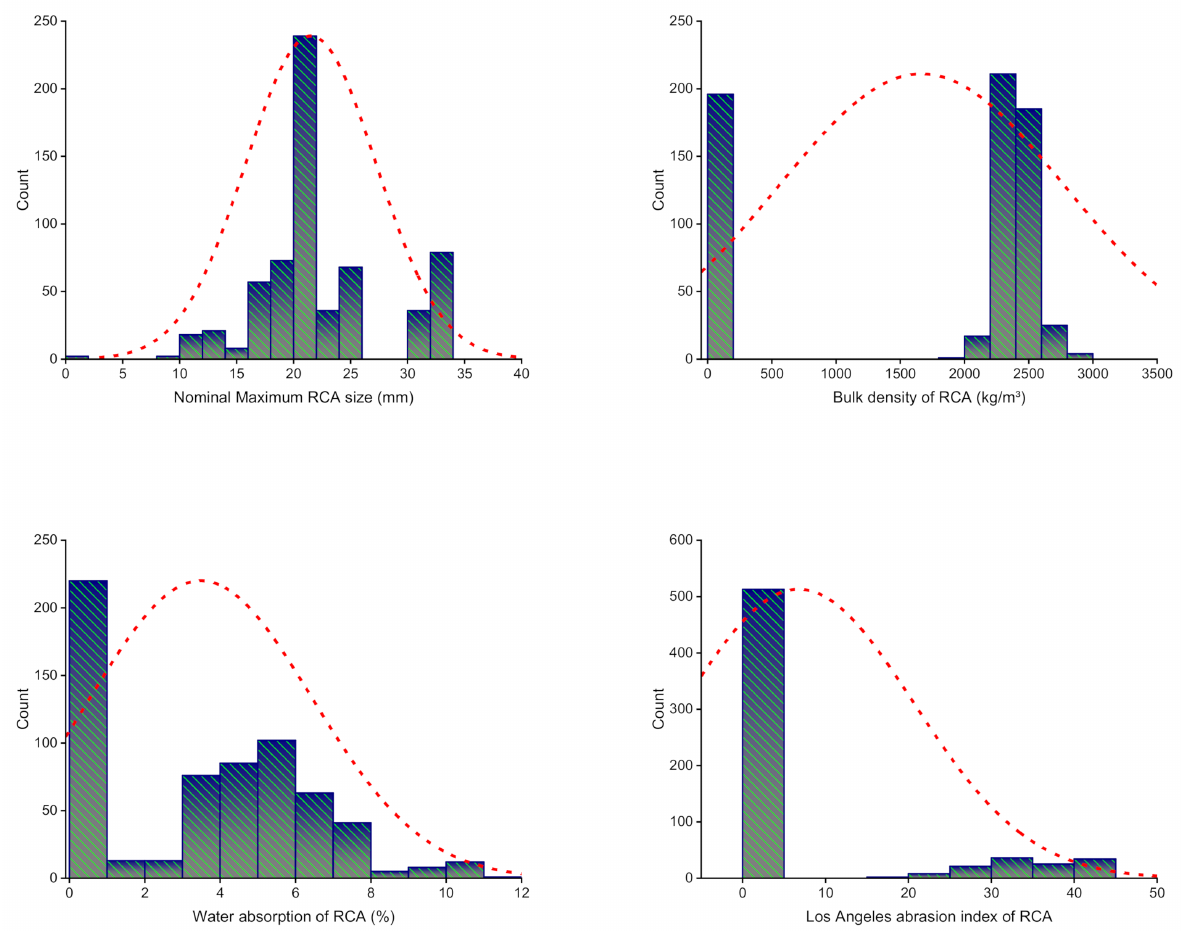
Figure 1. Relative frequency dispersal of input